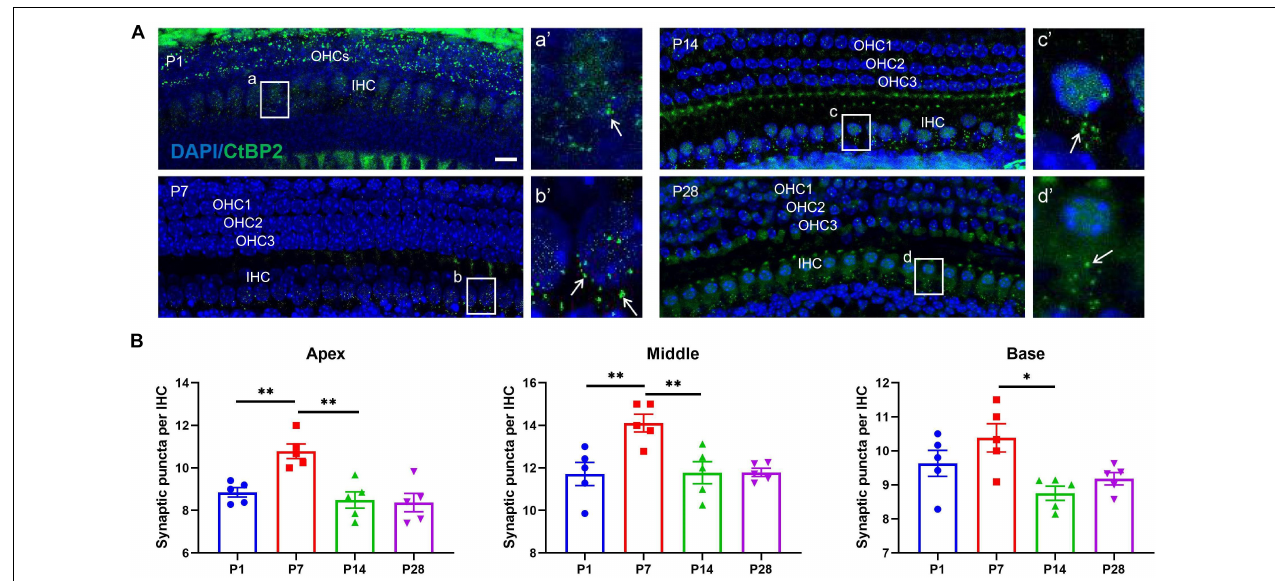
FIGURE 2 | Alterations in the number of ribbon synapses in the developing cochlea. (A) Whole mount of immunostaining at P1, P7, P14, and P28. Ribbon synapses were identified beneath the nuclei of IHCs using anti-CtBP2/RIBEYE (green, white arrow), and the nuclei of IHCs and OHCs were identified using DAPI staining (blue). A number of synaptic spots can be seen at P1 [ (a) white frame indicated; (a (cid:48) ) enlarged image of panel (a) ], and the highest number of synaptic puncta was identified at P7 [ (b) , white frame indicated; (b (cid:48) ) enlarged image of panel (b) ]. In contrast, reduced puncta of ribbon synapses appeared at P14 [ (c) , white frame indicated; (c (cid:48) ) enlarged image of panel (c) ] and P28 [ (d) white frame indicated; (d (cid:48) ) enlarged image of panel (d) ]. Scale bar = 5 µ m. (B) Quantitative analysis of changes in ribbon synaptic numbers in developing cochlea. Correspondingly, the largest number of ribbon synaptic puncta was found at P7 across the cochlear frequency (including the apex, middle, and basal turns), and a significantly reduced number of synaptic spots was observed at P14 and P28 (* p < 0.05; ** p < 0.01). IHC, inner hair cell; OHC, outer hair